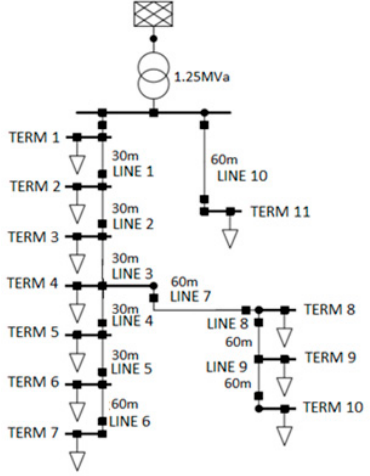
Figure 9. Simplified grid layout line diagram—single-phase equivalent.